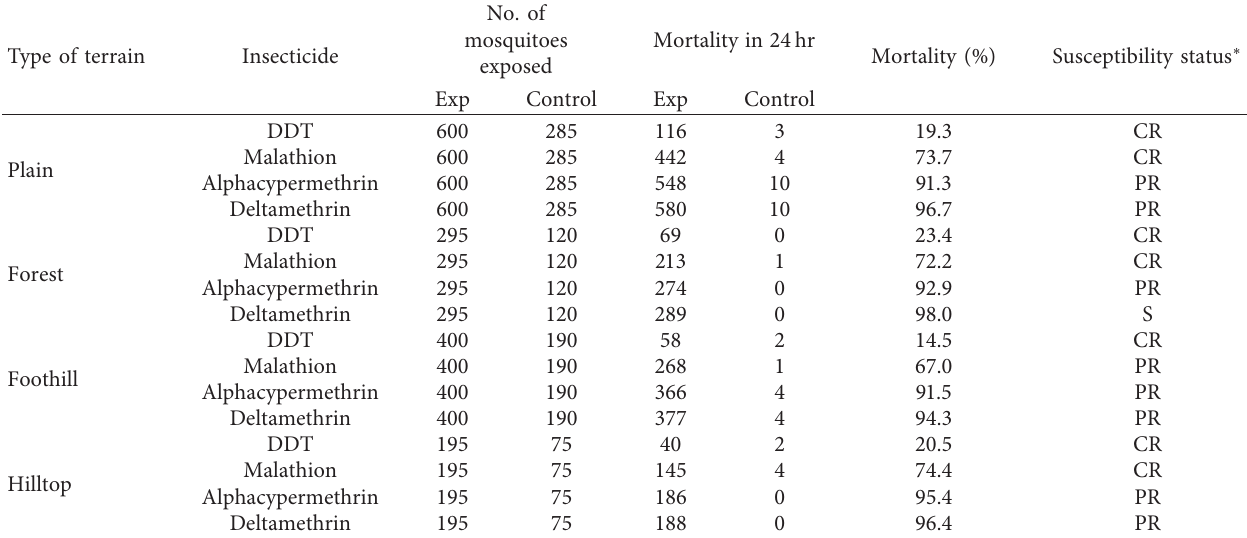
Table 4: Terrain-wise grouped insecticide susceptibility data in An. culicifacies . Type of